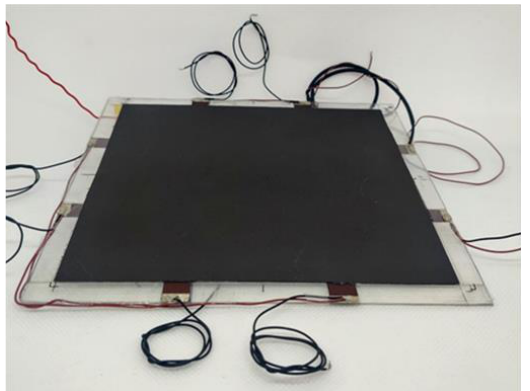
Figure 6. Picture of the final structure (SEAL) after the assembly of the RAS and the layers with the sensor array.